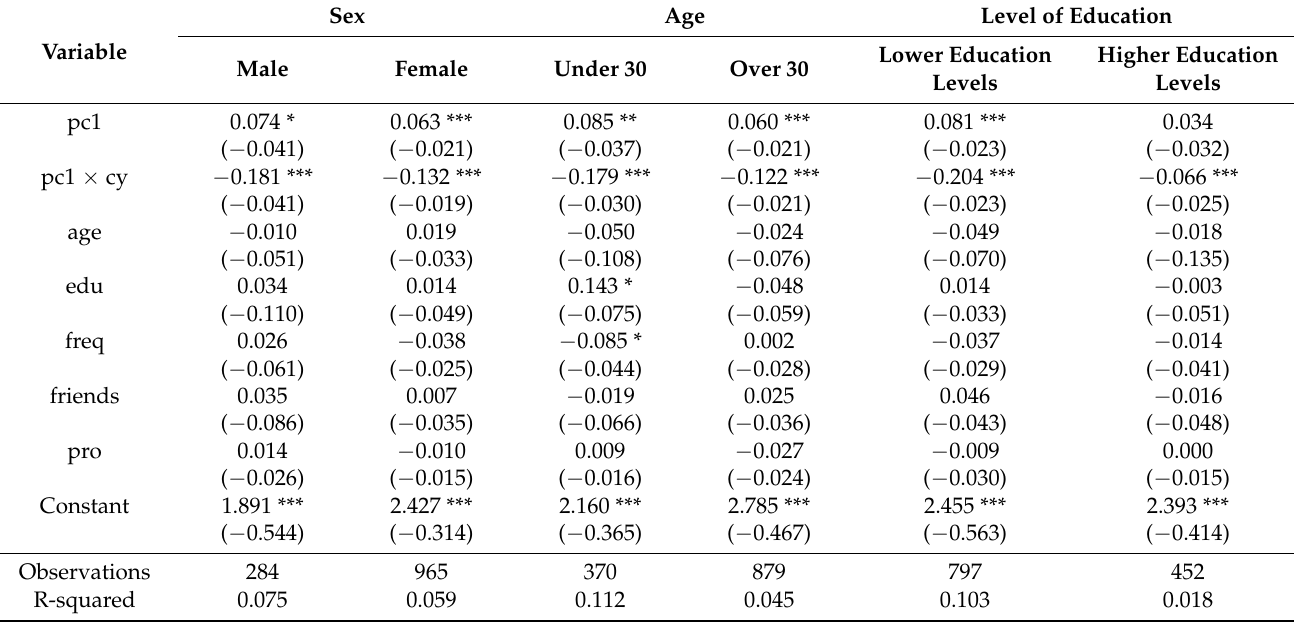
Table 9. The heterogeneity analysis of individual characteristics.